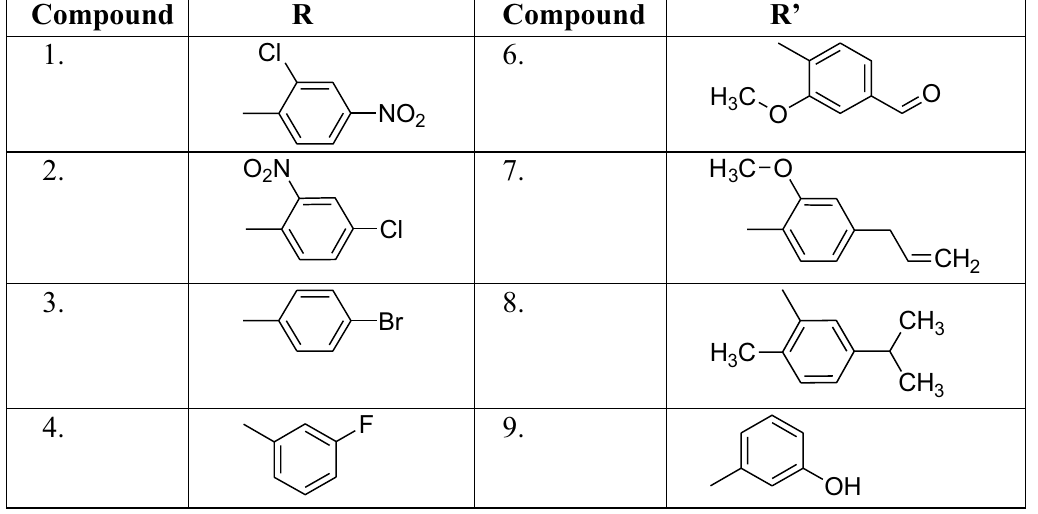
Table 2 Substituent for the design of caffeic acid derivatives (1–12) Compound